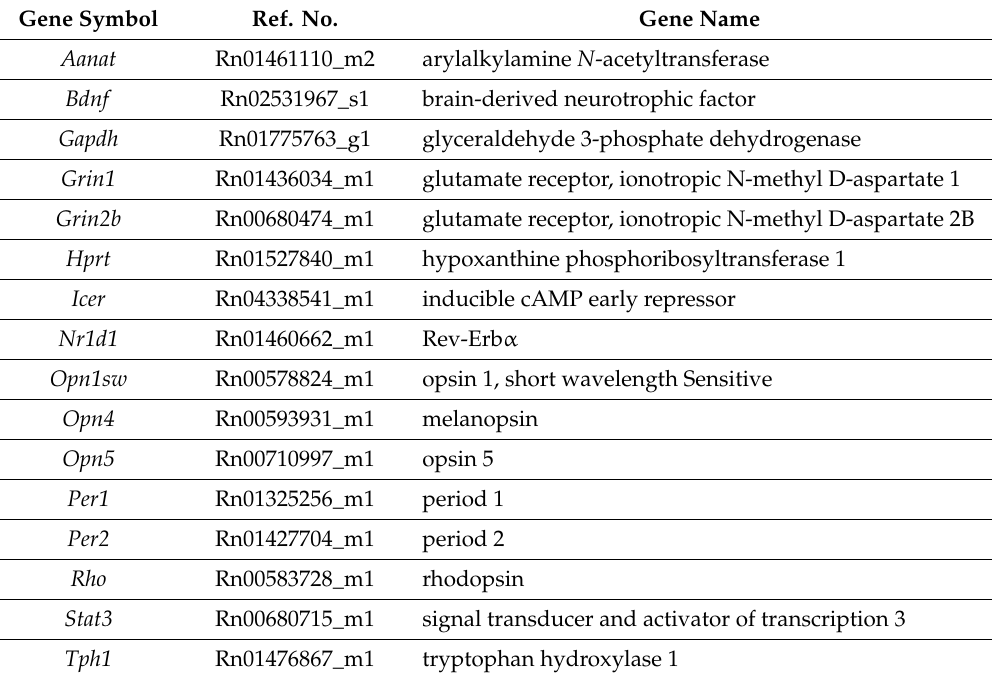
Table 1. List of the TaqMan probes used in this study. Gene Symbol Ref.